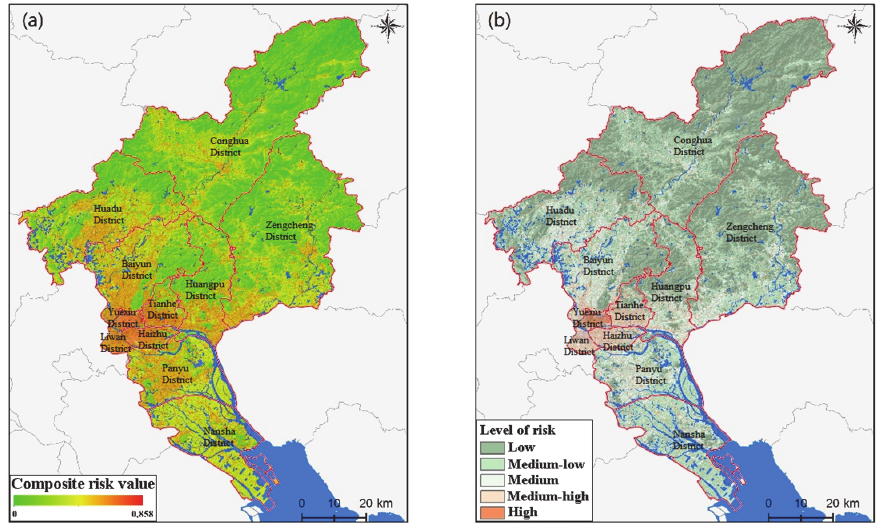
Figure 10. Spatial distribution ( a ) and grade division ( b ) of the comprehensive index of waterlogging disaster risk in Guangzhou.